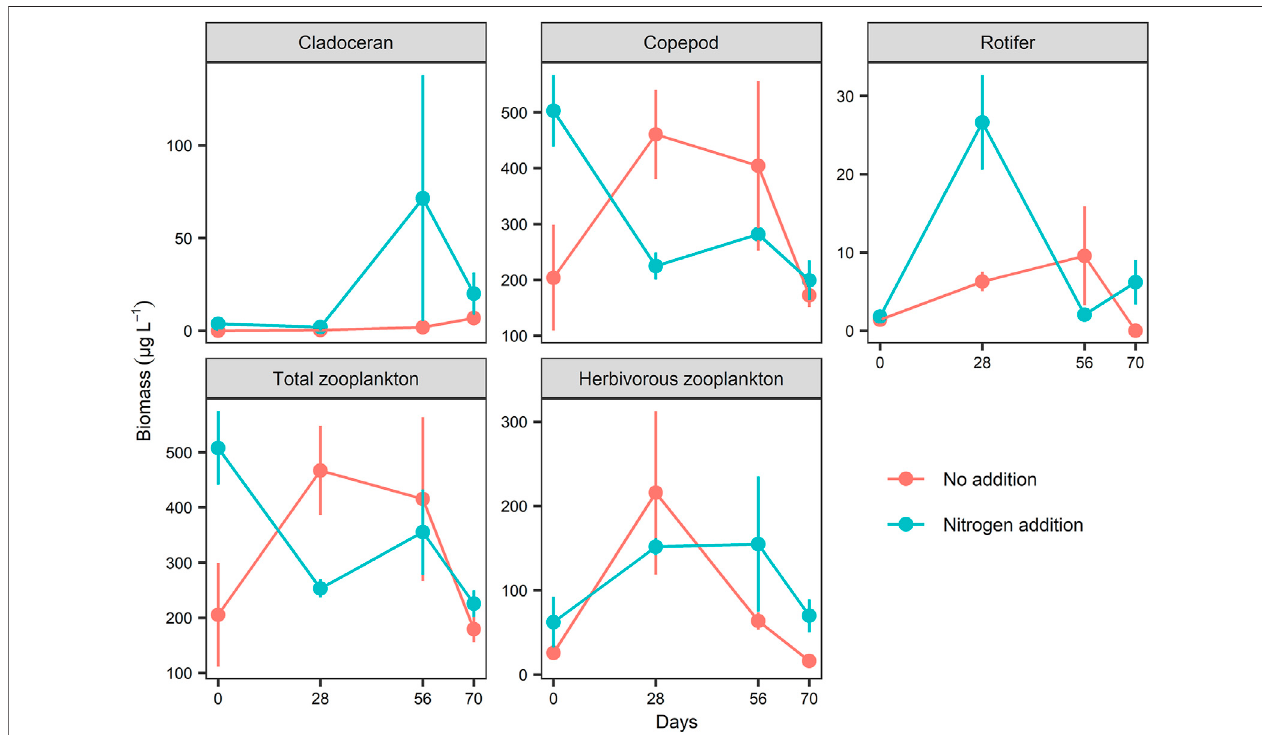
FIGURE 5 | Comparison of cladoceran, copepod, rotifer, total zooplankton and herbivorous zooplankton (without copepodites and adults of Mesocyclops leuckarti ) biomass (dry weight) between the two nitrogen treatments. Values represent mean ± SE ( n (cid:2) 3).